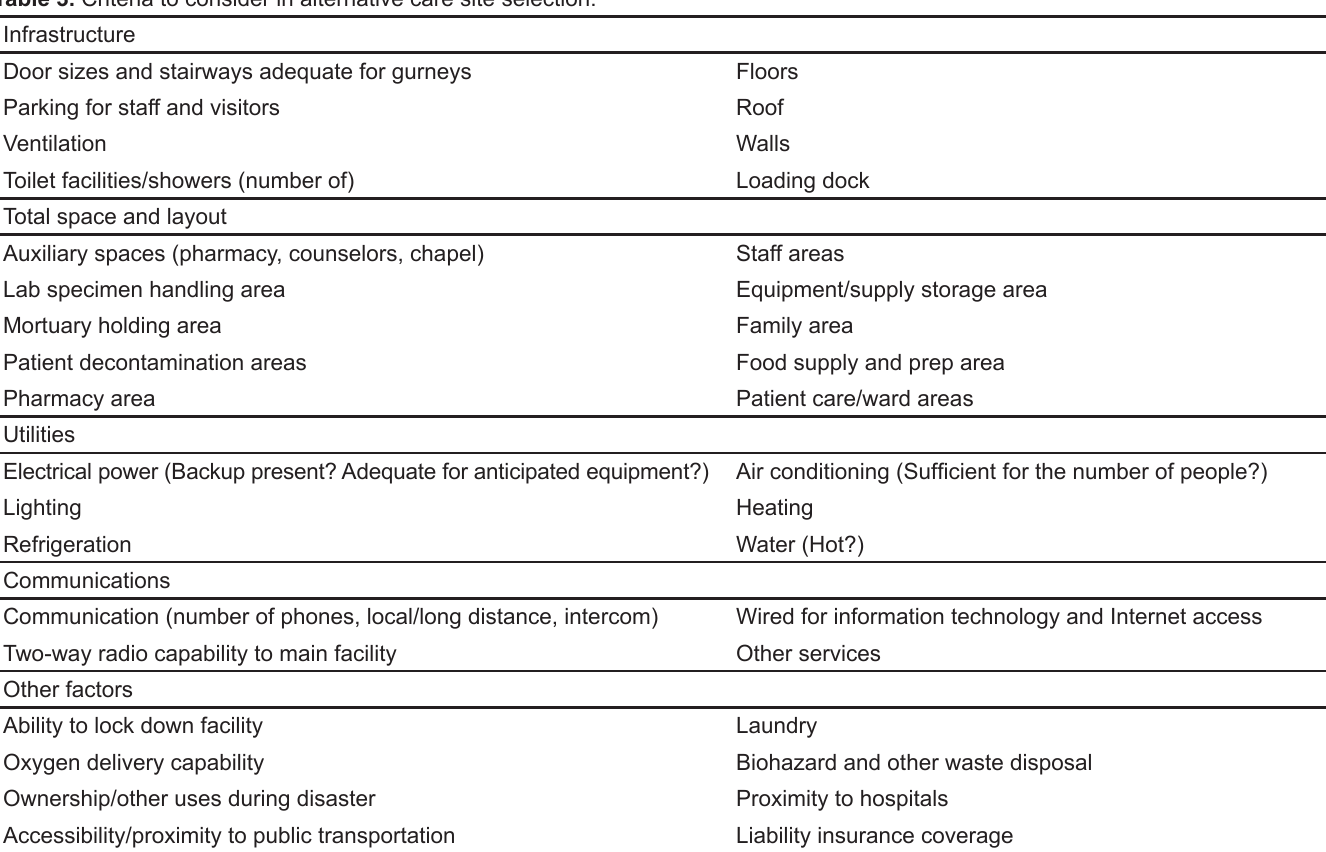
Table 3. Criteria to consider in alternative care site